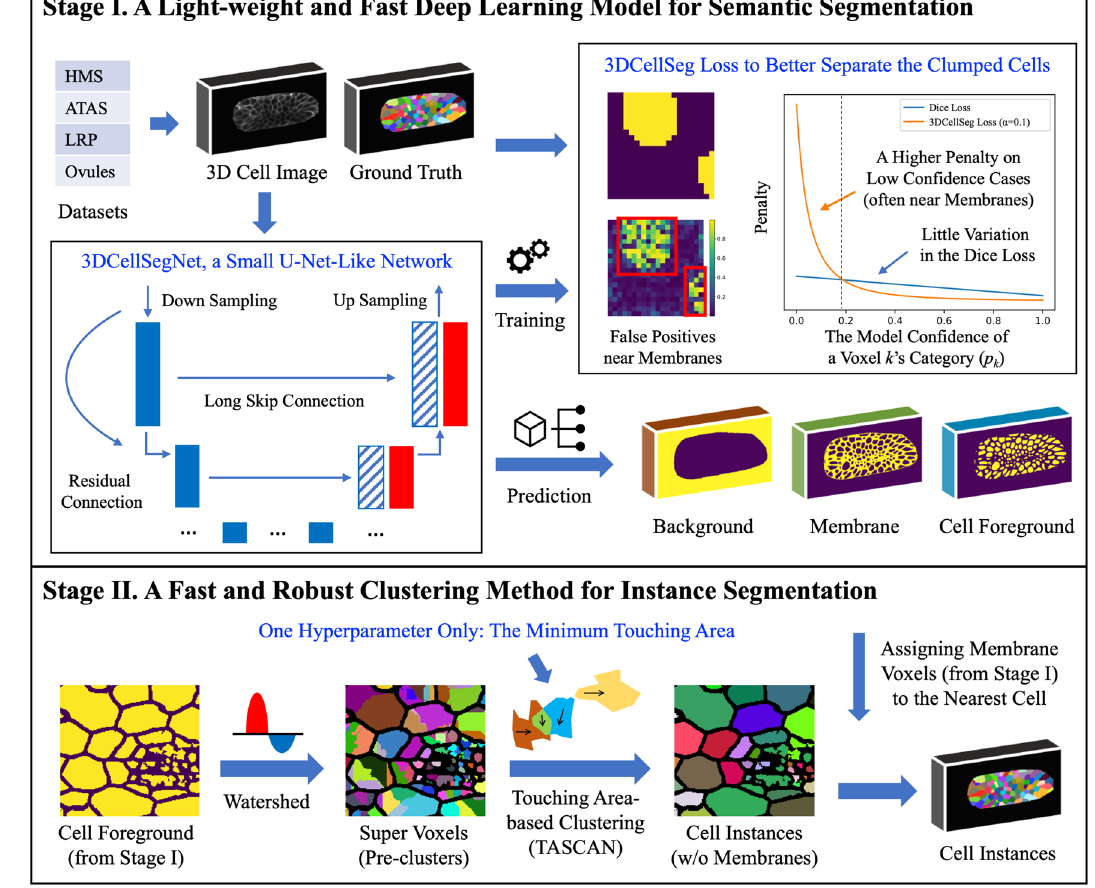
Figure 1. 3DCellSeg: A two-stage light-weight, fast, and robust pipeline for 3D cell segmentation. [Note: There are two stages in the pipeline. The first stage is a semantic segmentation, where the input is a 3D cell membrane image and the output consists of three masks, which indicate whether a voxel is the cell foreground, membrane, or background. The second stage is an instance segmentation performed on the basis of these three masks. The cellular images and segmentation results were generated by Python Matplotlib (https:// matpl otlib. org) using the HMS dataset].